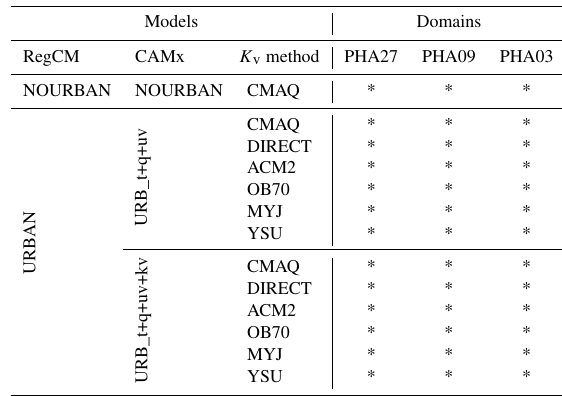
Table 1. Model simulations performed with RegCM (column 1) and CAMx (other columns). The second column denotes which urban effect is considered: NOURBAN – none; URB_t+q+uv – effect of temperature, humidity, wind; URB_t+q+uv+kv – effect of temper- ature, humidity, wind and turbulence. The third column lists the K v methods